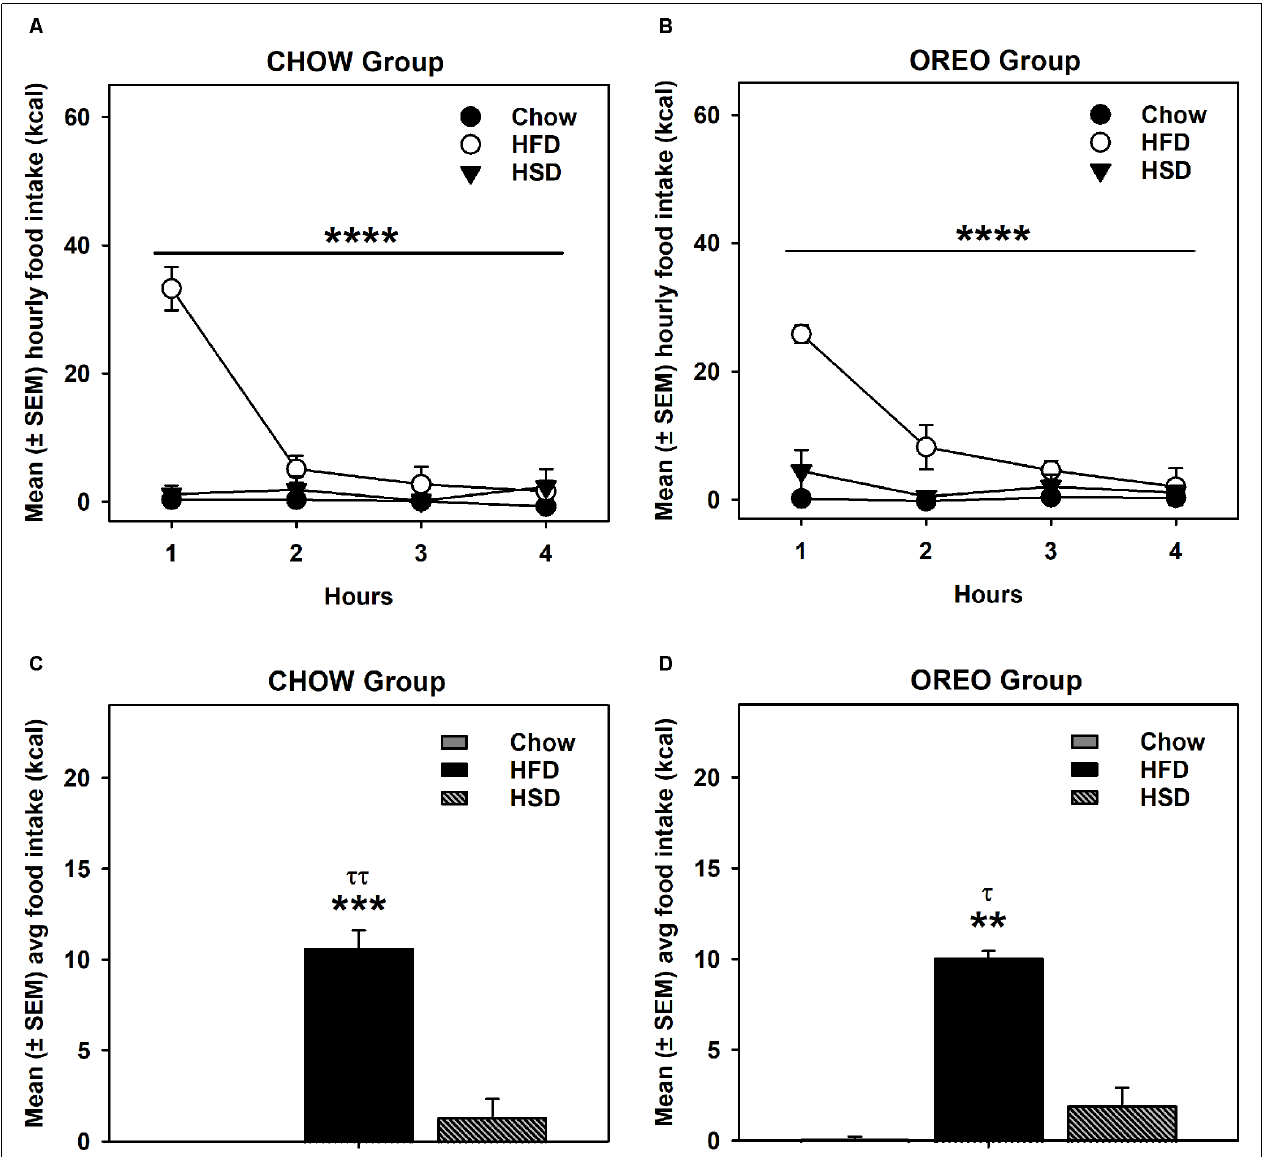
FIGURE 3 | HFD/HSD preference during acute withdrawal from patterned HPF feeding. In the 9th week, 24 h after the termination of intermittent HPF access, rats were tested for their HFD/HSD preference. Data represent mean ( ± SEM) hourly and average food intake from each diet (chow, HFD, and HSD). A significant between-diet effect was noted in the hourly food intake in both Chow (A) and Oreo (B) groups. **** p < 0.0001 between diet effect. A significant preference of HFD over both HSD and chow was noted in both Chow (C) and Oreo (D) groups. However, no significant between diet type differences in HFD or HSD intake were evident. There was no significant preference for HSD compared to chow in either group. ** p < 0.01, *** p < 0.001 compared to chow. τ p < 0.05, ττ p < 0.01 compared to HSD. HFD, high-fat diet; HSD, high-sugar